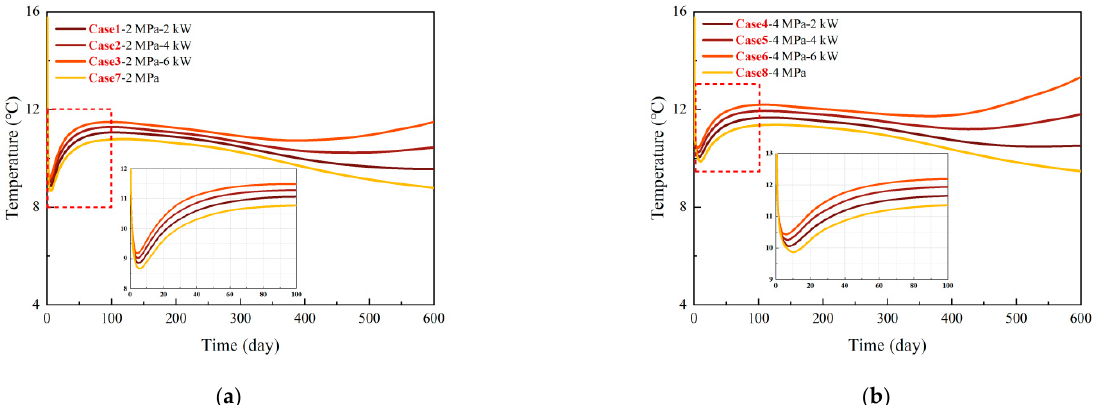
Figure 11. Temperature evolution of the open-hole section of wellbore: ( a ) production pressure of 2 MPa; ( b ) production pressure of 4